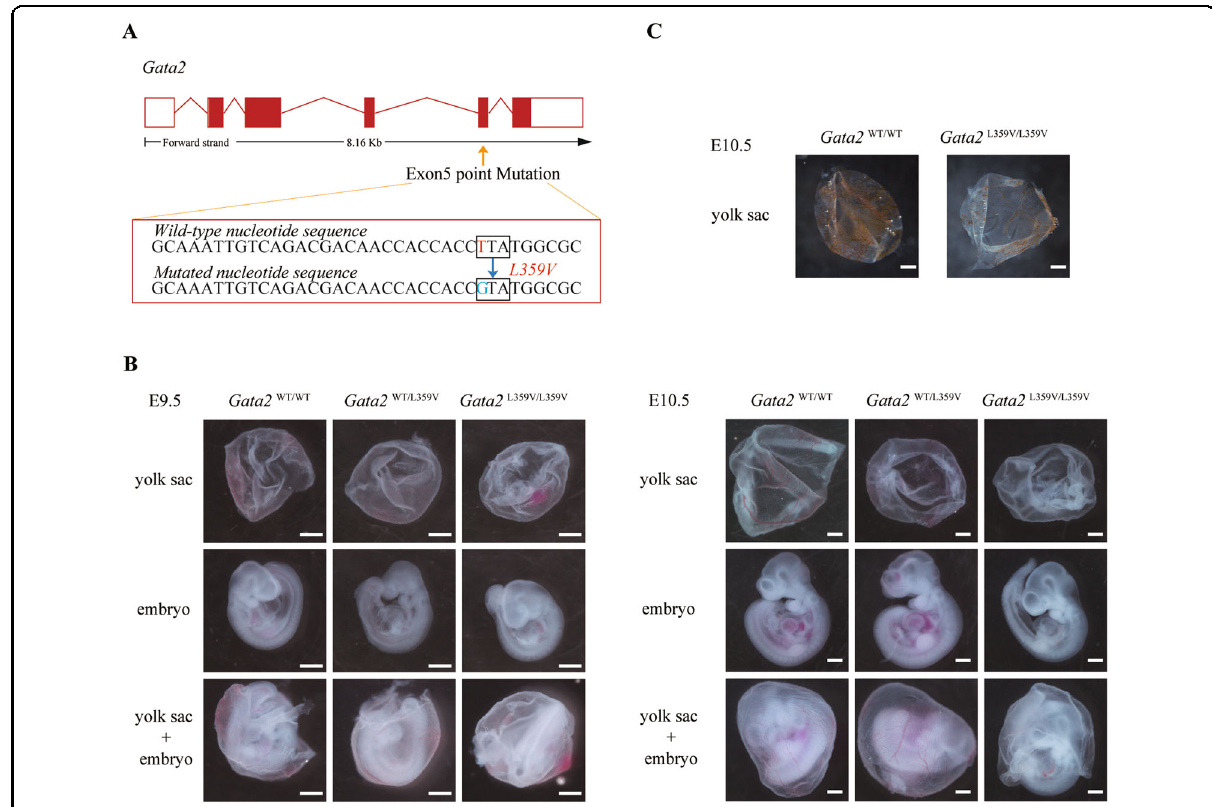
Fig. 1 Anemia phenotype in Gata2 L359V/L359V embryos. A Schematic of the Gata2- L359V knockin murine model. The L359V mutation was introduced into the ZF2, which is located in the exon 5 of the murine Gata2 gene. B Morphology of embryos and yolk sacs of different genotypes at E9.5 (left panel, scale bar 500 μ m) and E10.5 (right panel, scale bar 500 μ m). C O -dianisidine staining of hemoglobin in yolk sac erythrocytes (scale bar 500 μ